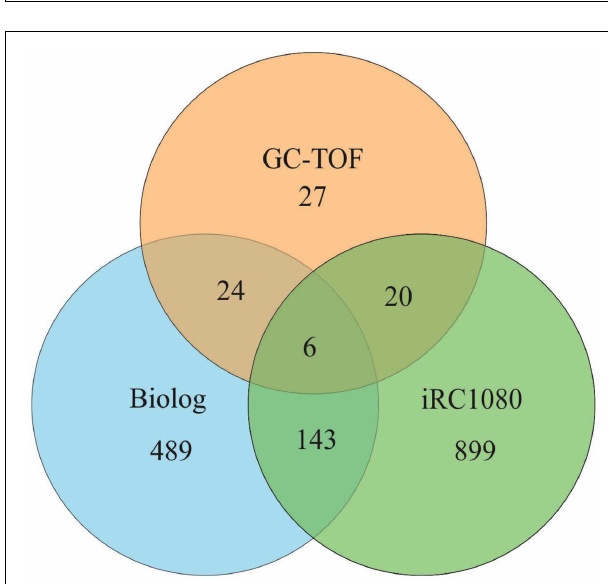
FIGURE 3 | Reproducibility of PM tests . OmniLog values were collected over a 168h period and the maximum values were plotted for two replicate studies. Each axis represents the maximum OmniLog values for each study (the x -axis being one replicate study and the y -axis another). Identical values fall on a 45° line; there are a few deviating test values (some deviations were by more than 50 units). Each point represents a single maximum OmniLog value.